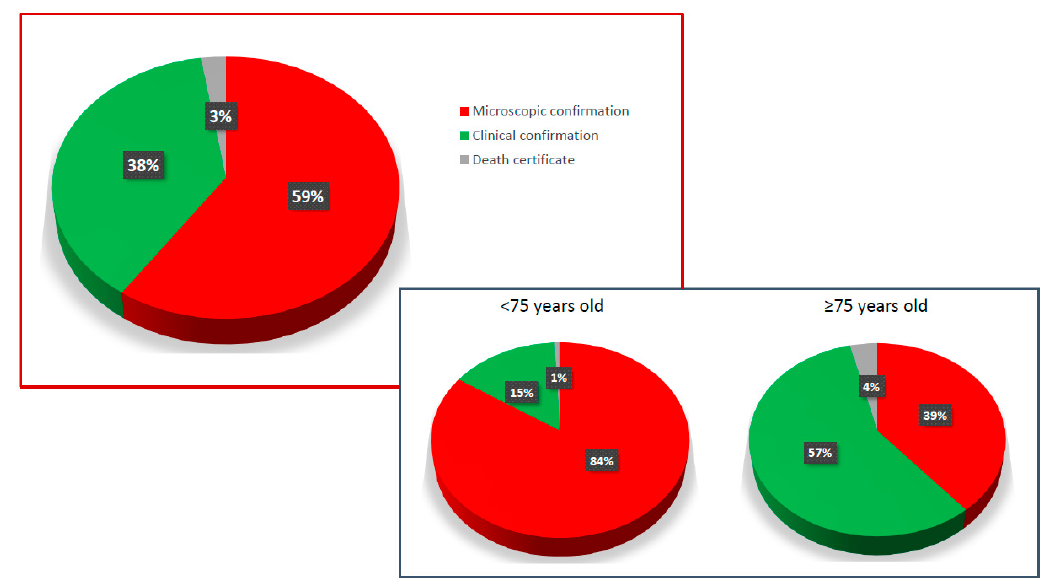
Figure 3. Types of diagnostic confirmation for PC patients of the Veneto region population. Microscopic confirmation included all PC patients with histological confirmation, obtained either by biopsy on primary lesions or metastases, or by surgery. Clinical confirmation included all cases of PC patients without histological diagnosis.